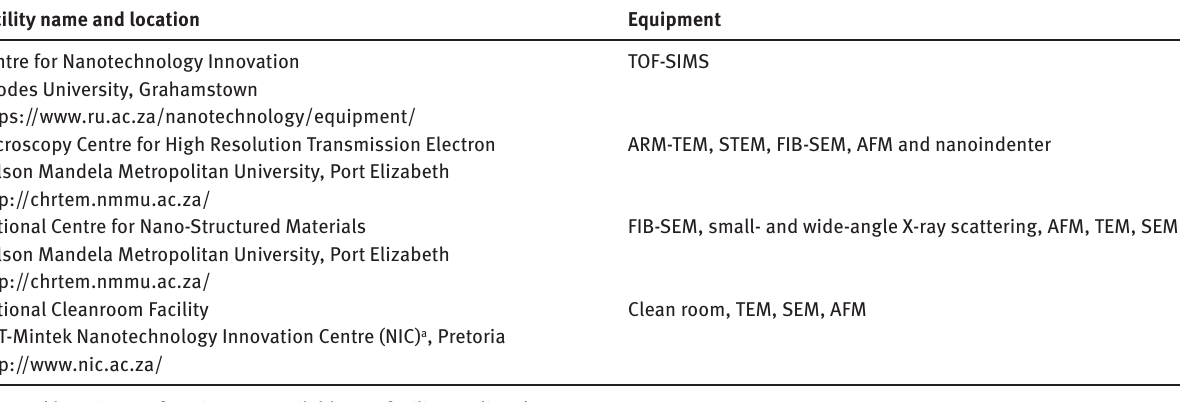
Table 1: List of the key national nanotechnology facilities in South Africa. Facility name and